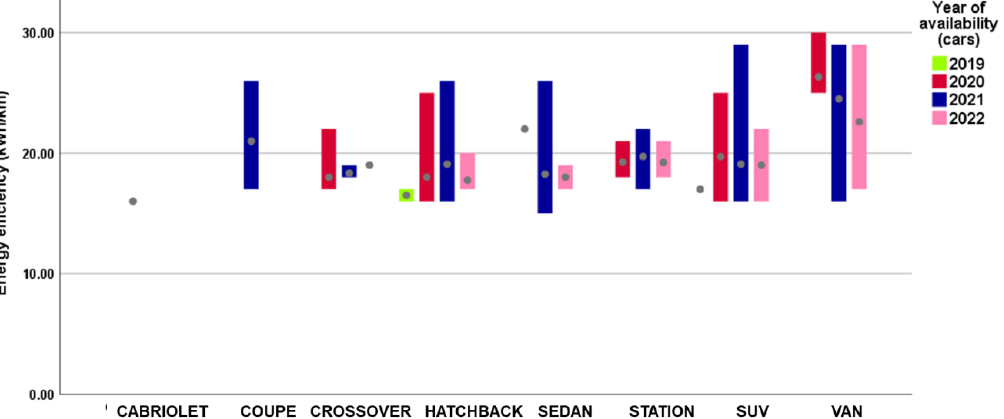
Energies 2023 , 16 , x FOR PEER REVIEW Figure 17. Range bar variation (min, max, mean) representation of energy efficiency vs. type of cars. Figure 17. Range bar variation (min, max, mean) representation of energy efficiency vs. type of cars. Figure 17. Range bar variation (min, max, mean) representation of energy efficiency vs. type of cars.